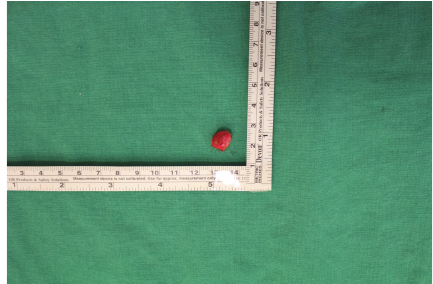
Figure 2: The gross appearance of the lesion indicates a unilocular cyst with brown mucinous